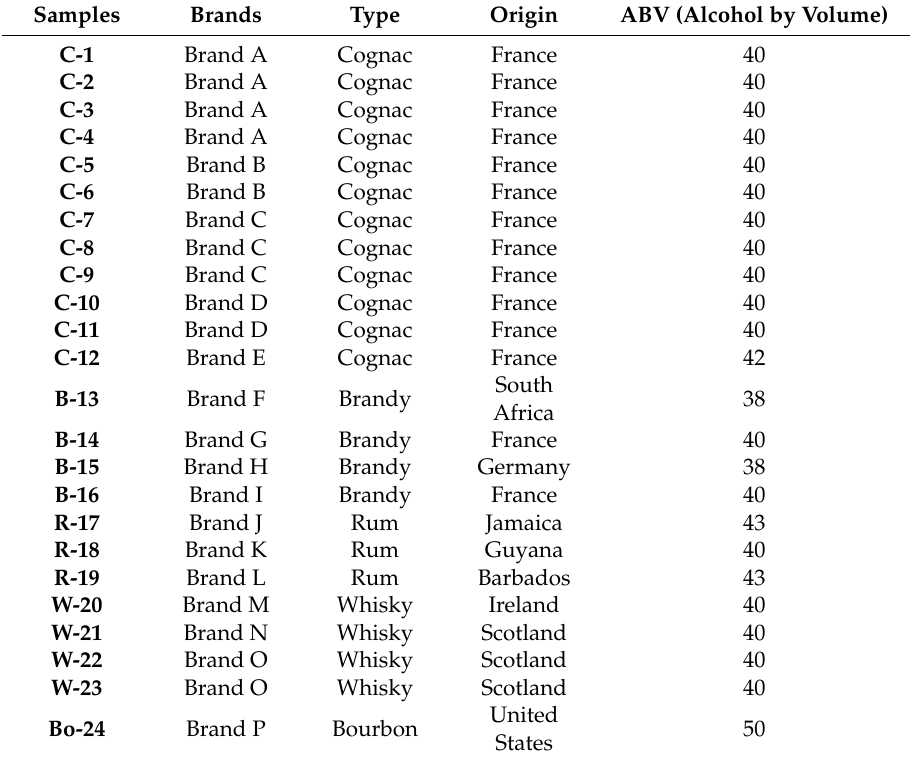
Table 3. Features of commercial